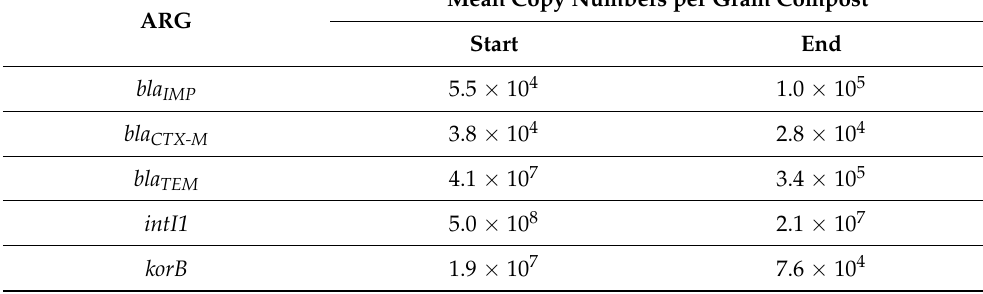
Table 3. Mean copy numbers of ARGs and horizontal gene transfer marker genes irrespective of the treatment with and without biochar, as assessed by qPCR. Copy numbers were normalized to 1 g